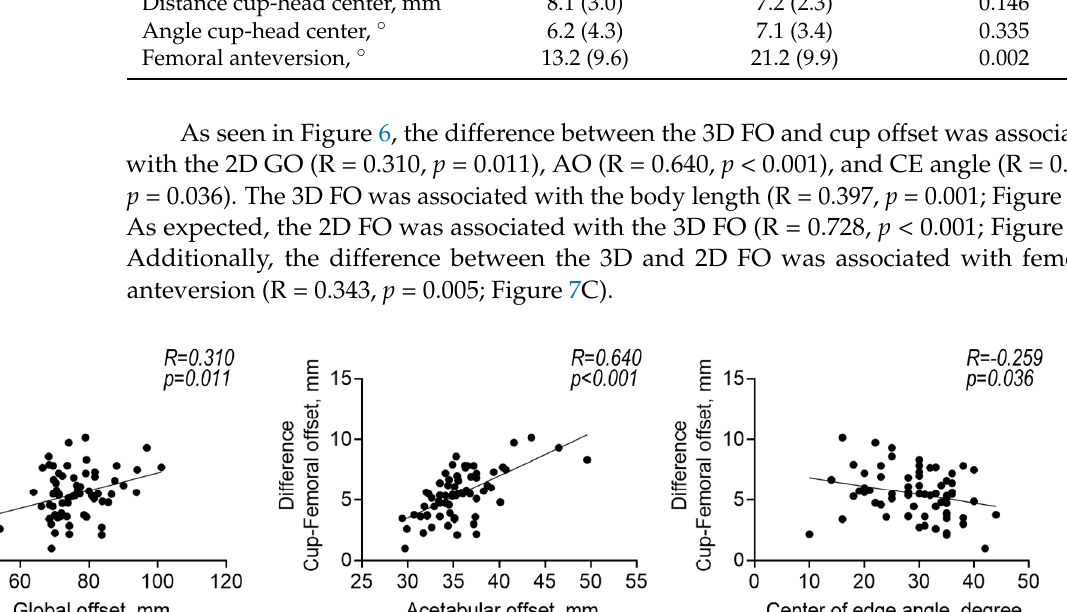
Figure 7. Correlations between ( A ) the body length and three ‐ dimensional femoral offset, ( B ) two ‐ dimensional and three ‐ dimensional offset, and ( C ) femoral anteversion and difference three ‐ two ‐ dimensional femoral offset. 4. Discussion A recent registry study revealed that implant choice is a factor associated with im ‐ plant survival following THA [25]. Therefore, the selection of an implant that matches the anatomical features seems to be key to the safe placement and durability of the prosthesis. Additionally, to optimize function, hip mechanics should be restored to as near normal as possible. Determining the appropriate offset in THA is important from the perspective of the effect on the joint forces and range of motion applied to the hip by the acquisition of dislocation resistance and definition of the lever arm of the abductor muscle. In addition to FO and AO, the GO (which is the distance from the pubic symphysis to the femoral axis) should be evaluated for the hip offset. In the past, preoperative and postoperative evaluations were often performed using 2D frontal radiographic images of the hip joint. However, in recent years, 3D evaluation using CT has improved our understanding of the anatomy and enabled detailed preoperative and postoperative planning and evaluation. Factors that determine the offset include the thickness of the acetabular base, the presence or absence of a double floor, joint congruity, deformation of the femoral head, and ante ‐ version and cervical angles of the femur. The position of the hip center on the affected and healthy sides should be accurately evaluated in two and three dimensions using simple radiography and CT, and the offset should be determined from the viewpoint of biome ‐ chanics (kinematics and kinetics) during movement. This study primarily aimed to investigate the 3D FO length in the Japanese popula ‐ tion, in order to determine its potential for use in the selection or manufacture of appro ‐ priate implants that match the anatomical features. The mean 3D FO length in this study was 40.0 mm (men, 42.1 mm; women, 38.4 mm), which was smaller than that reported previously in the Western population [26,27]. As expected, the findings suggest that the FO may tend to be smaller in the Asian population than in the Western population. Alt ‐ hough Takamatsu et al. reported that there were no correlations between the FO length